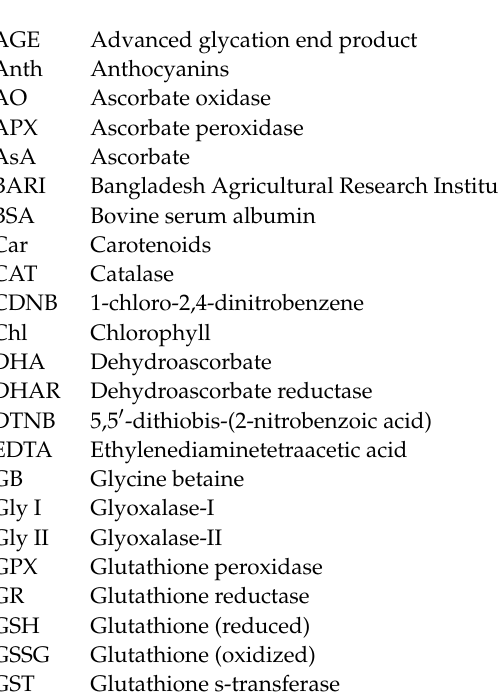
Bangladesh; Table S2: Stress tolerance index (STI) of studied variables; Table S3. Variance components (%) of morphological, physiological and biochemical variables in the context of wheat varieties × heat stress using the general linear model and Table S4. Morphological variables of wheat varieties grown under control and heat stress conditions. SL- shoot length, RL- root length, SDM- shoot dry matter, RDM- root dry matter, TDM- total dry